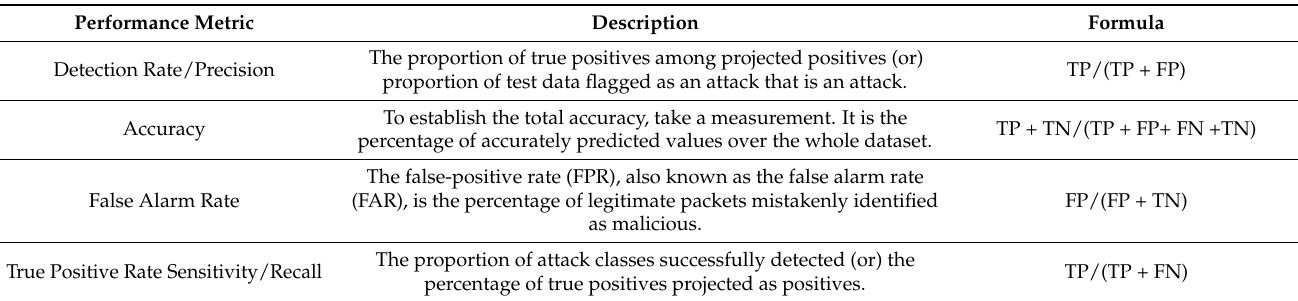
Table 6. IDS Performance Measures